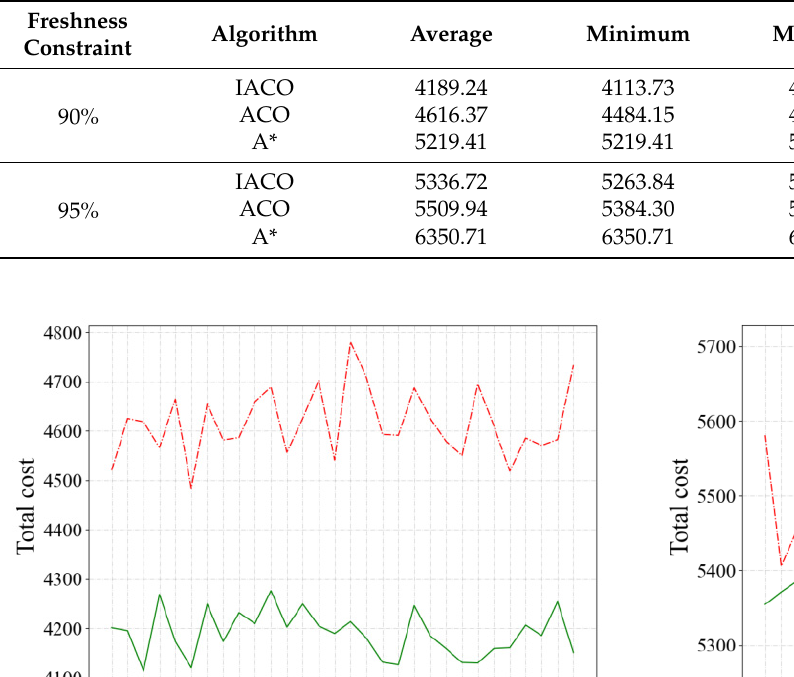
Table 5. Comparison of different algorithms with all the results.